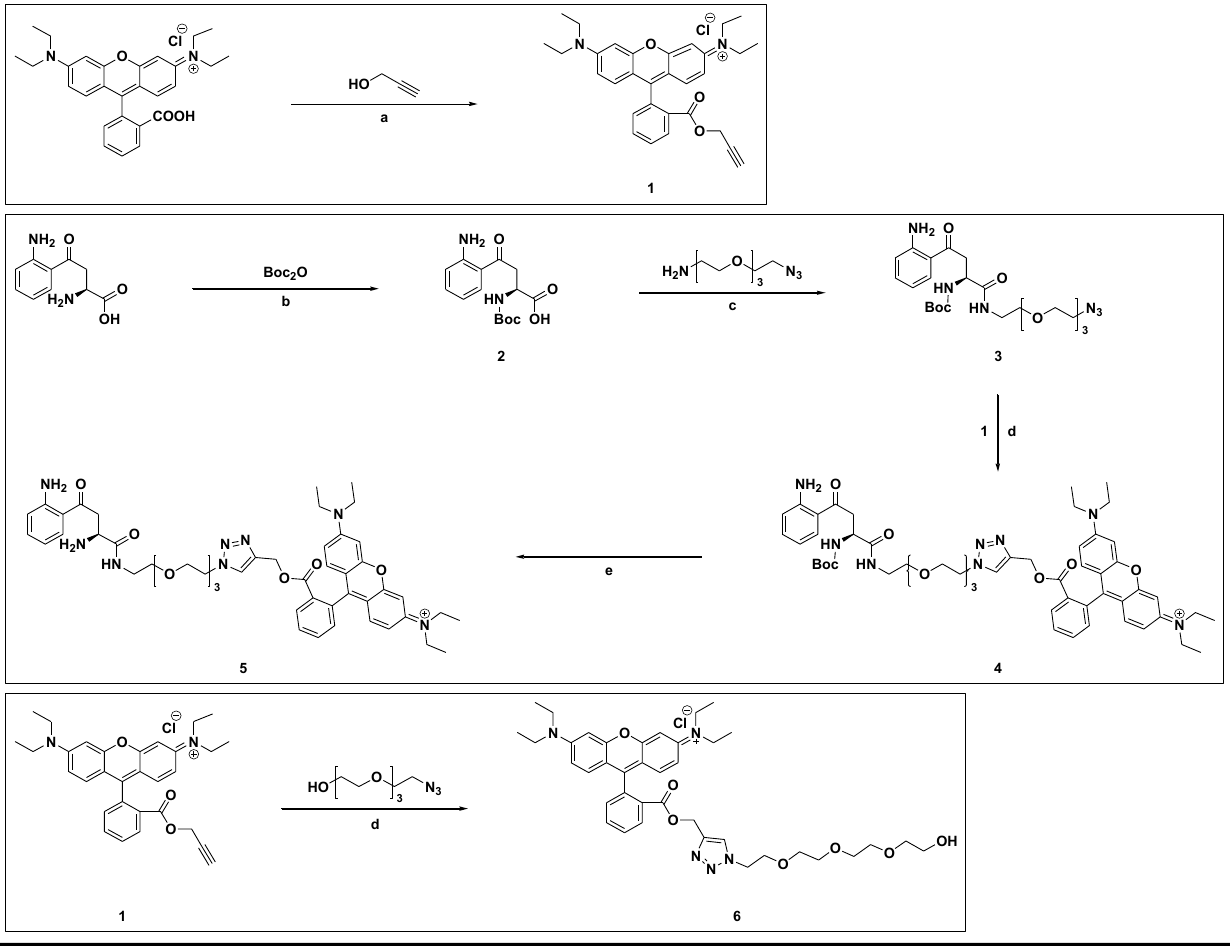
Figure 1. Route of synthesis for the fluorescent labelled kynurenine probe. Rhodamine B was reacted with propargyl alcohol to rhodamine B propargyl ester 1 , which was reacted with an azido tetraethylene glycol linker to afford 6 or with azido-kynurenine to yield product 5 . Reaction conditions: